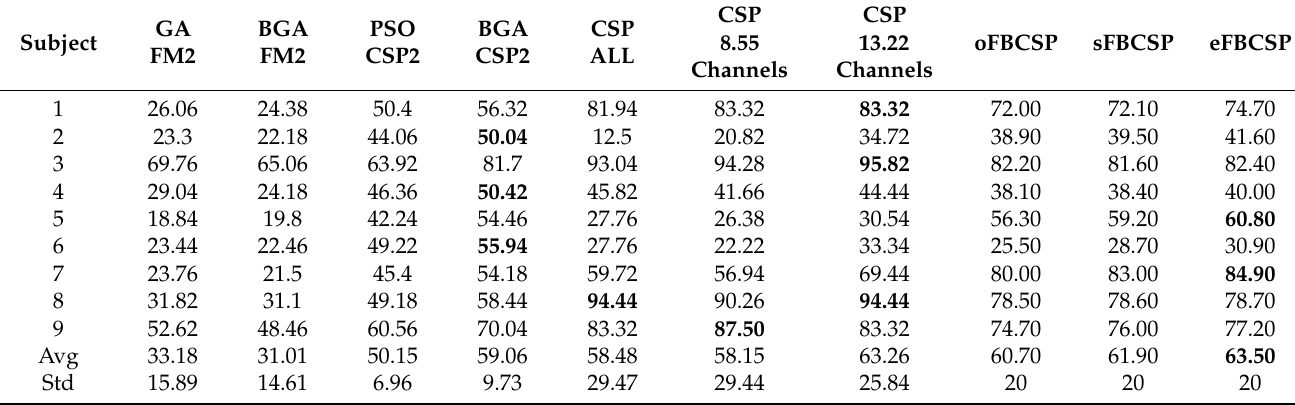
Figure 15. Examining the best kappa different methods for selecting features (along with feature extraction, reducing features and channels, etc.) on three channels, 8, 10, and 12, by combining different selected bands. Table 20. Examining the best kappa different methods for selecting features (along with feature extraction, reducing features and channels, etc.) on three channels with more than three channels by combining different selected bands and so